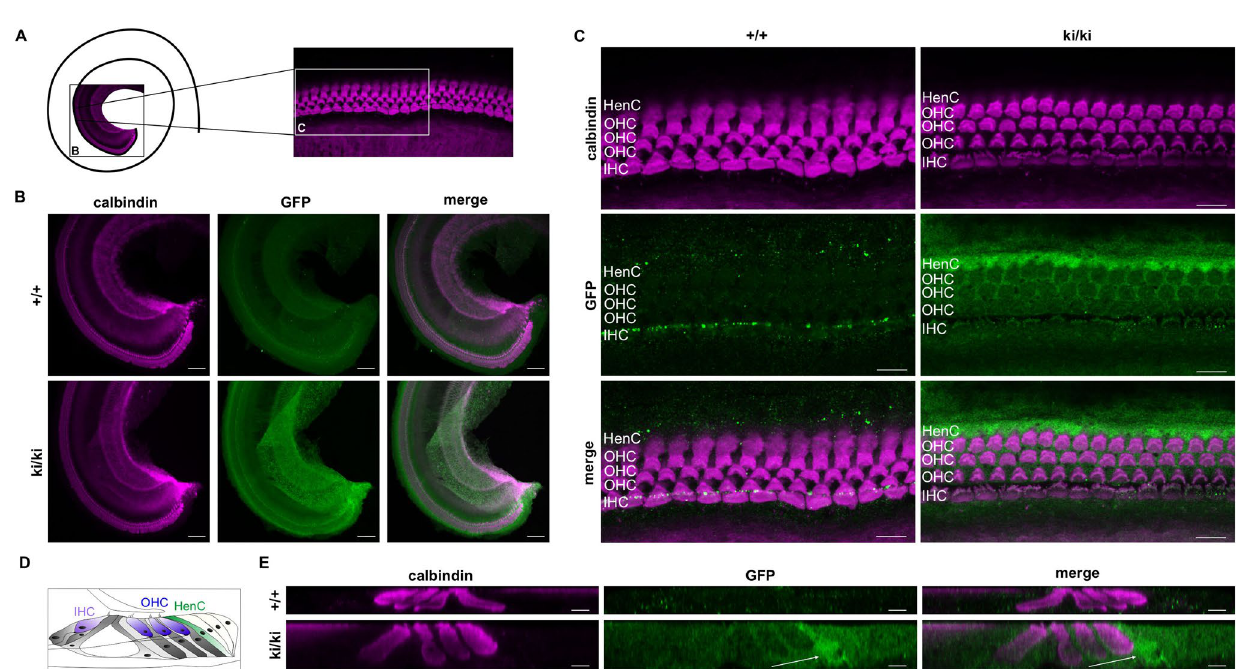
Figure 5. GFP expression in the cochlea of Gnai3 -iresGFP reporter mice at P8. ( A ) Scheme of a top view onto the apical turn of the cochlea and the sites of low and high magnification views shown in ( B , C ). ( B ) Representative low magnification view of a wild-type (top) and a ki/ki (bottom) organ of Corti (P8) stained against calbindin (magenta) and GFP (green). GFP expression is restricted to the ki/ki genotype. Calbindin, used to visualize outer (OHC) and inner hair cells (IHC), is detectable in wild-type and ki/ki organs of Corti. Maximum projection of confocal sections is depicted. ( C ) High magnification views (single optical sections) of OHCs and IHCs immunolabeled for calbindin (magenta) and GFP (green) from wild-type and ki/ki animals (P8). GFP expression was strongest in the first row of Hensen’s cells (HenC). ( D ) Scheme of an orthogonal cross- section through the organ of Corti. ( E ) Virtual orthogonal cross-section through the organ of Corti displaying one IHC, three OHCs and supporting cells of wild-type and ki/ki mice double-labelled for GFP (green) and calbindin (magenta). Arrows indicate HenC. Images of wild-type and ki/ki were acquired and displayed with the same settings. Scale bars ( B ) 20 µm, ( C ) 10 µm and ( E ) 5